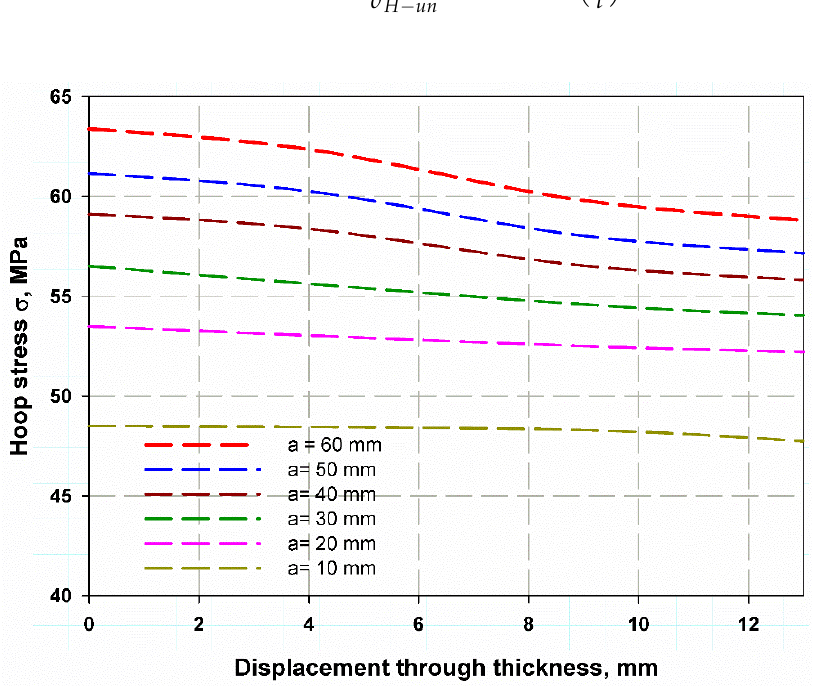
Figure 12. Hoop stress distribution across the thickness.